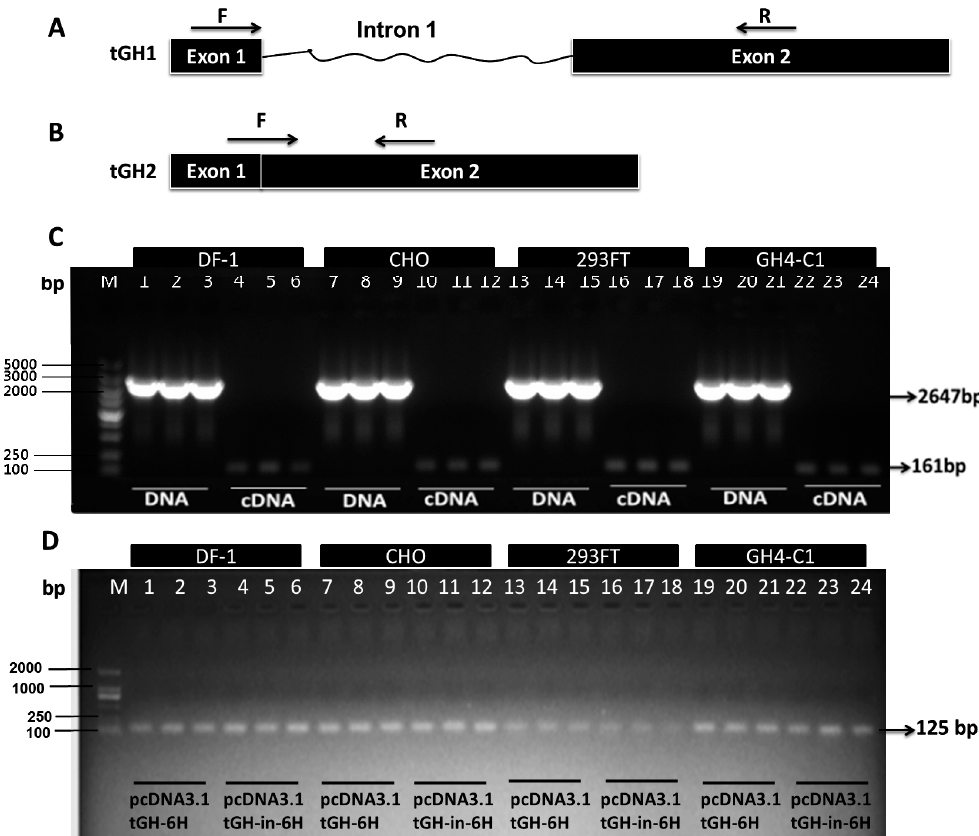
Figure 4. PCR product confirms the correct splicing of tGH intron 1 in DF-1, CHO, 293FT, and GH4-C1 cell lines at 48 h post-transfection with pcDNA3.1tGH-6H or pcDNA3.1tGH-in-6H. ( A ) Schematic diagram showing the position of tGH1 primes in tGH gene, which were depicted by arrows. Forward primer was located on exon 1, and reverse primer was located on exon 2; ( B ) Schematic diagram showing the position of tGH2 primes in tGH gene, which are depicted by arrows. Forward primer was located at the junction of exon 1 and exon 2, and reverse primer was located on exon 2; ( C ) Electrophoresis map showing the PCR product generated from the four cell lines post-transfection with pcDNA3.1tGH-in-6H. tGH1-F and tGH1-R were used as the primers, which were depicted in ( A ). DNA or cDNA from the four cell lines was used as template, marked by the white bold characters; ( D ) Electrophoresis map showing PCR products generated from the four cell lines post-transfection with pcDNA3.1-tGH-6H or pcDNA3.1-tGH-in-6H. tGH2-F and tGH2-R were used as the primers, depicted in Figure 4B. The temples were cell cDNA from the four cell lines transfected with pcDNA3.1-tGH-6H or pcDNA3.1-tGH-in-6H, which are marked by white or black bold characters. The lanes show the cell samples chosen at random from the four cell lines in ( C , D ). Expression of the plasmids pcDNA3.1tGH-6H and pcDNA3.1tGH-in-6H was compared across